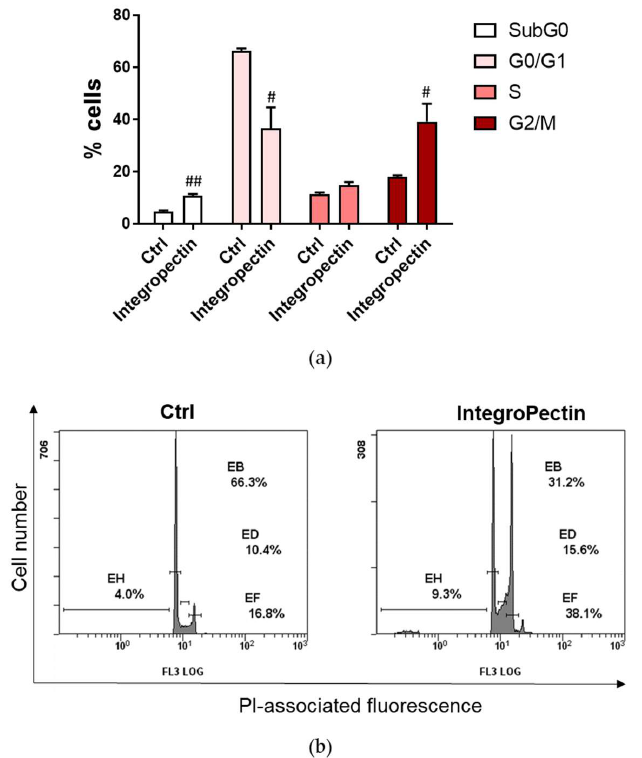
Figure 2. ( a ) Effect of grapefruit IntegroPectin on the cell cycle distribution of SH-SY-5Y cells. Per- centage (%) of cell distribution of untreated (Ctrl) cells and cells treated for 24 h with IntegroPectin (1 mg/mL) in different phases of the cell cycle, assessed by flow cytometry analysis after propidium iodide (PI) staining ( n =12); ( b ) Representative images. t-test: # p < 0.05, ## p < 0.01 as compared to iodide (PI) staining ( n = 12); ( b ) Representative images. t -test: # p < 0.05, ## p < 0.01 as compared control (Ctrl) group.